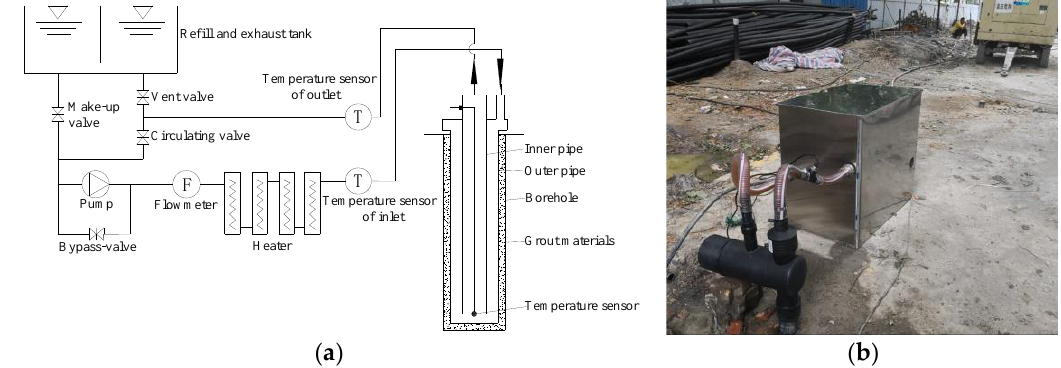
Figure 2. Diagram of thermal response test (TRT) equipment. ( a ) Schematic diagram of TRT. ( b ) Physical diagram of TRT.